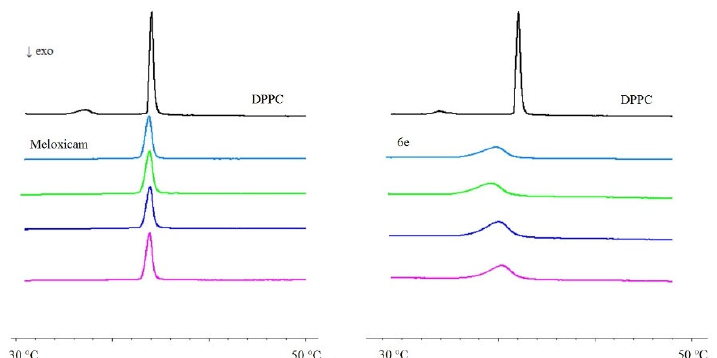
Figure 4. The example thermograms obtained for DPPC mixed with meloxicam ( left ) and compound 6e ( right ) as well as for pure lipid (the first curve from the top—black color). Curves in the Figure represent the thermograms obtained for different molar ratios (studied compound: DPPC—from the bottom: 0.12, 0.10, 0.08, 0.06, pure lipid). The exothermic direction in this graph is down ‐ ward.